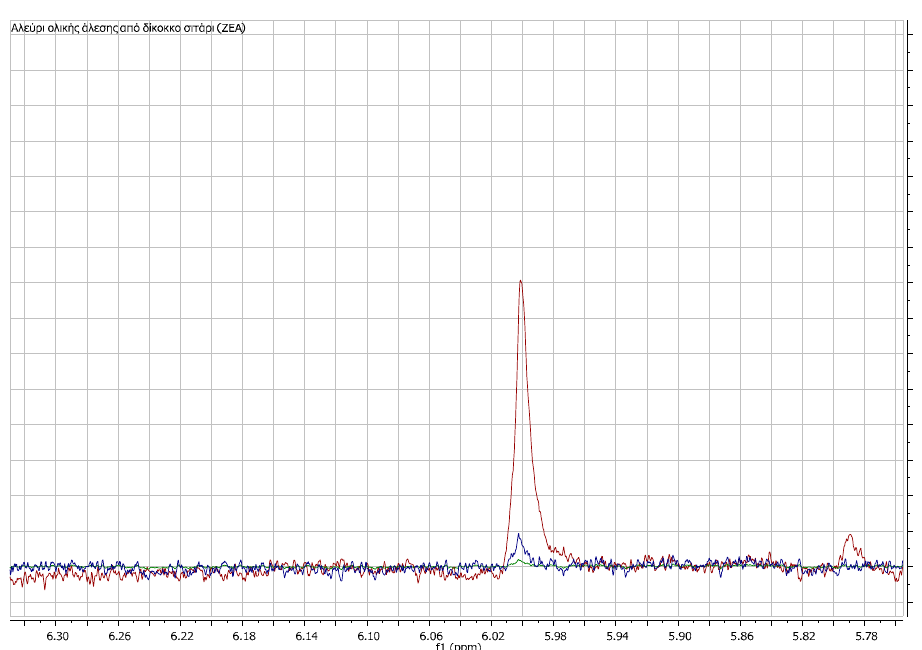
Figure A5. NMR spectrum of flour extract in CD 3 OD.